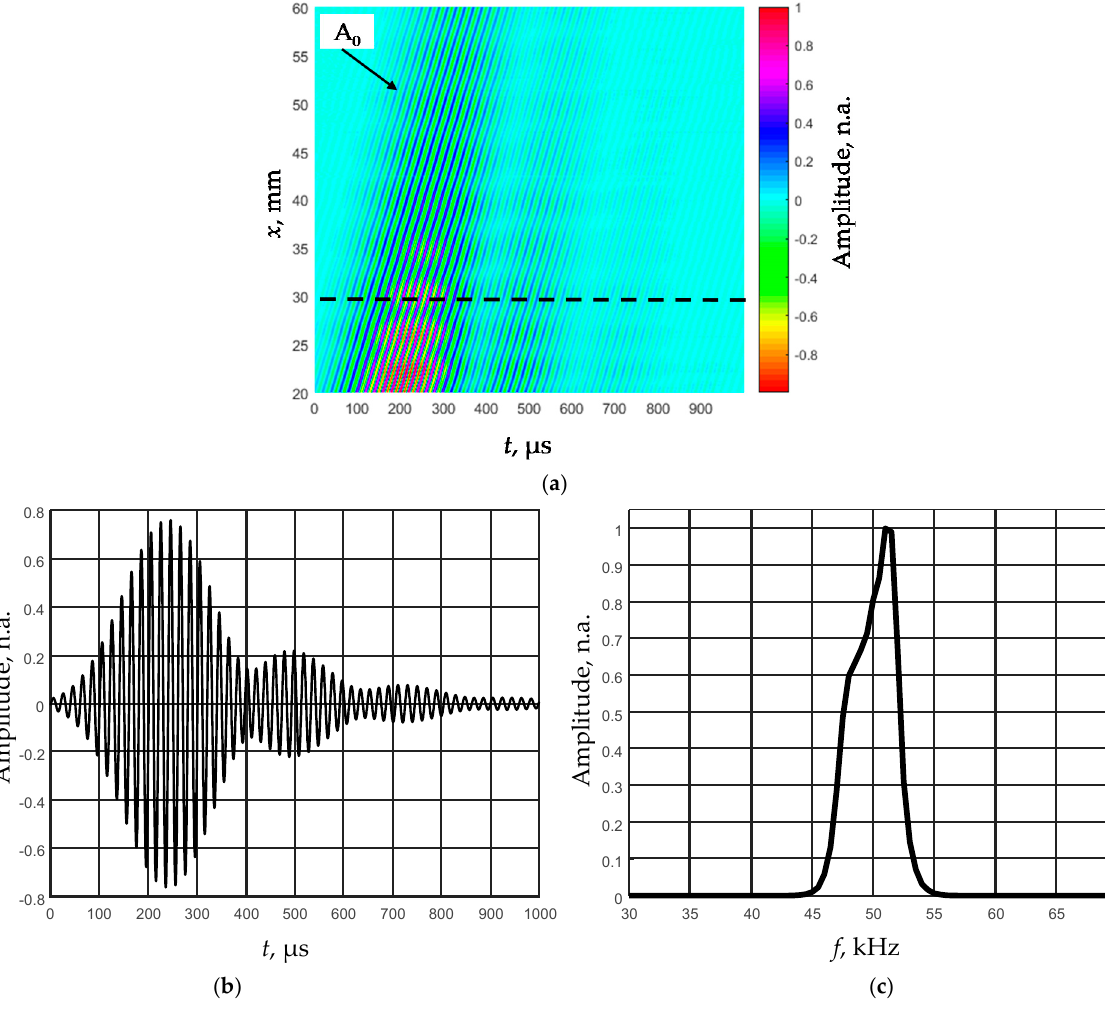
Figure 10. Air-coupled excitation of the A 0 mode at the low frequency (50 kHz) in 150 µm thickness PVC film: B-scan image of the normal displacements obtained after filtering of the ultrasonic signals with the Gaussian filter ( a ), the filtered signal at the distance of 30 mm from the transmitter ( b ), and the frequency response of this signal ( c ).